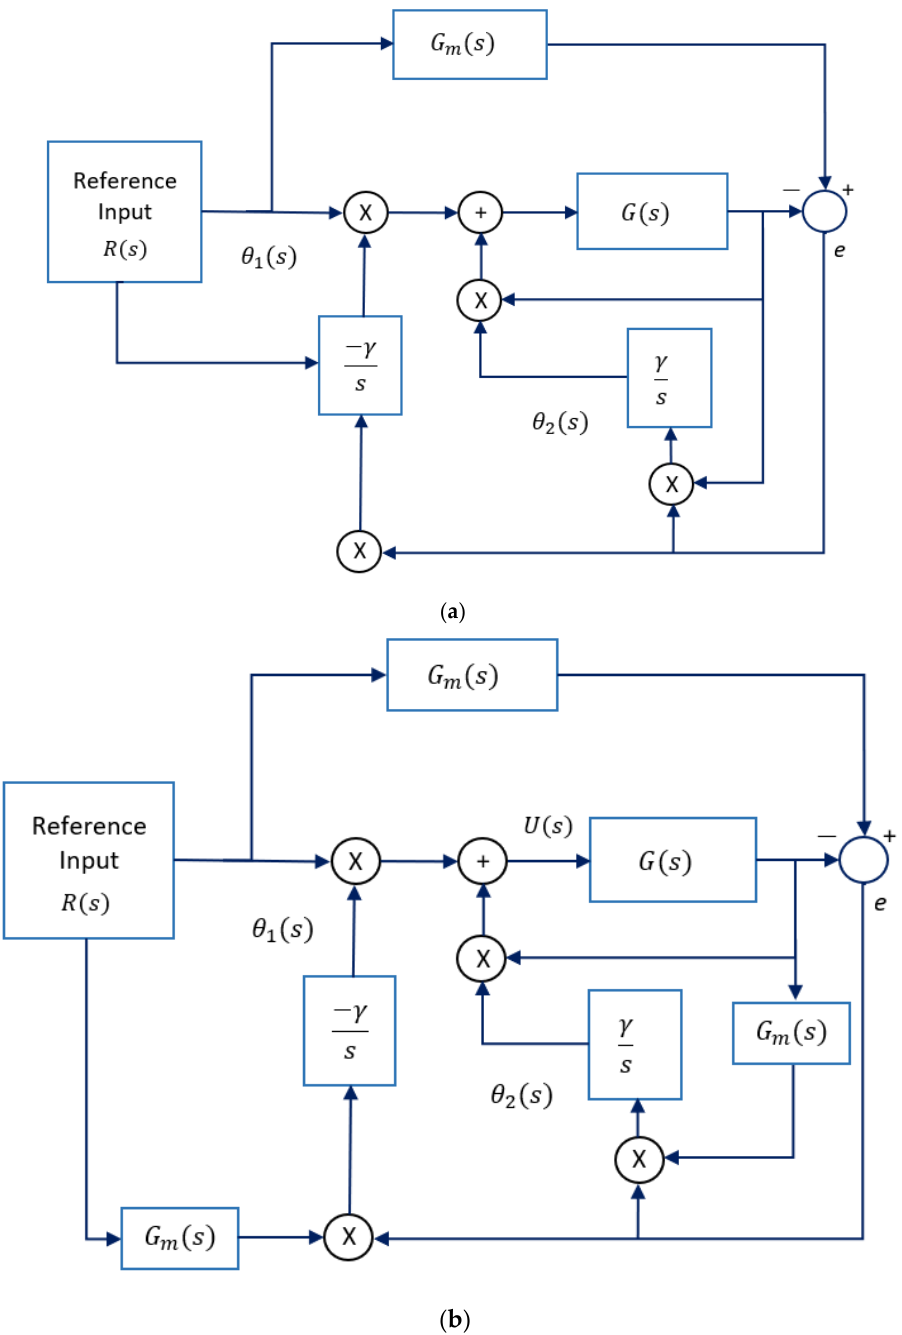
Figure 4. MRAC block structure applied to gas cleaning tank level control process.